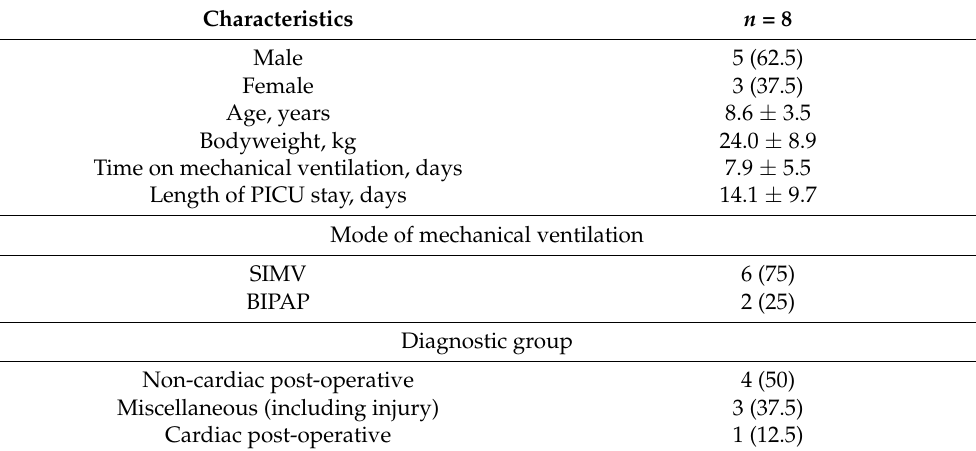
Table 1. Clinical characteristics of the included